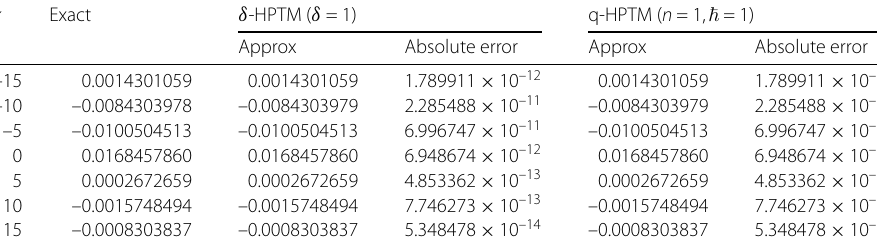
Table 2 The comparative study of Im[ W (3) ] solutions of δ -HPTM, q-HATM, and exact solution for